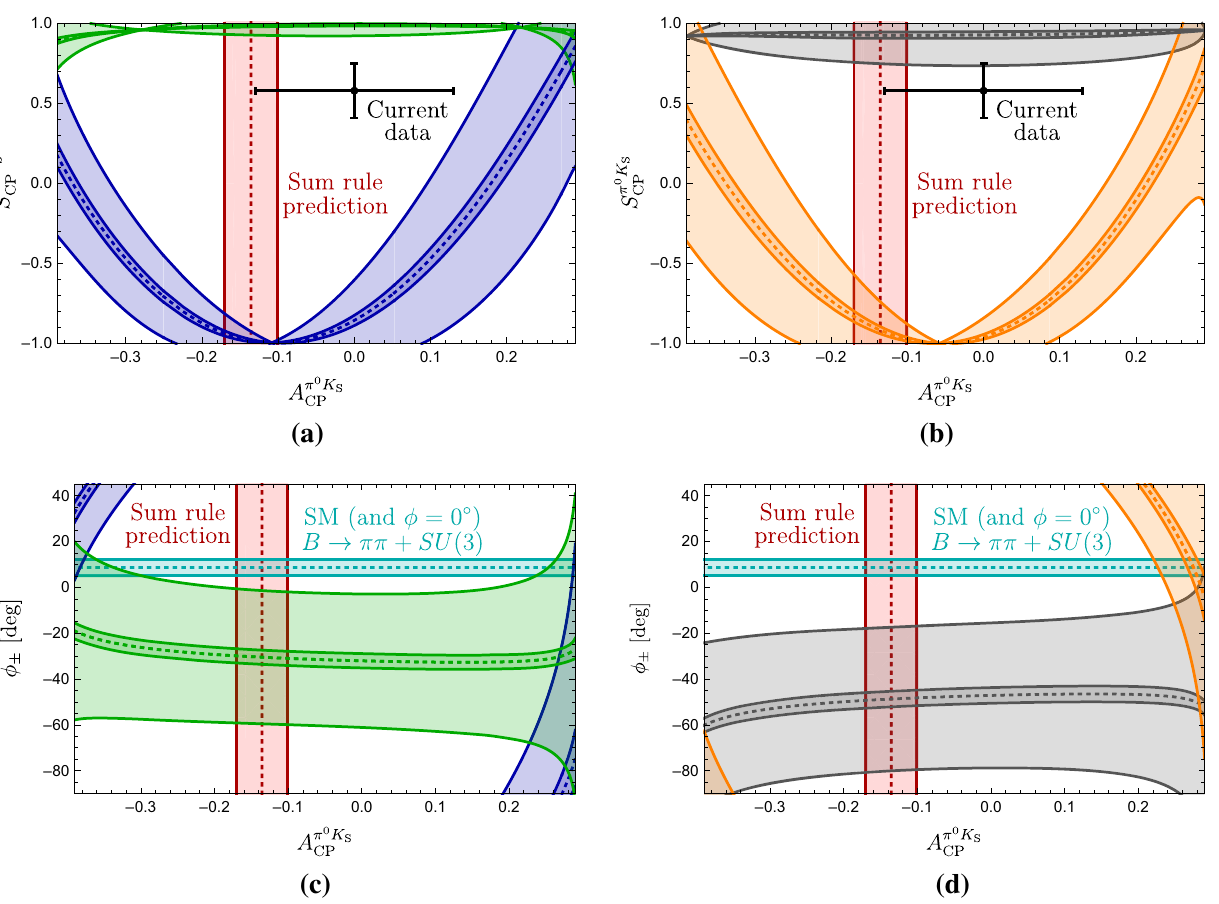
→ π 0 K the triangle configurations we show the associated angle φ ± . The hor- S d izontal band (blue) gives the current SM constraint in Eq. (122). The narrow bands correspond to a future scenario discussed in the